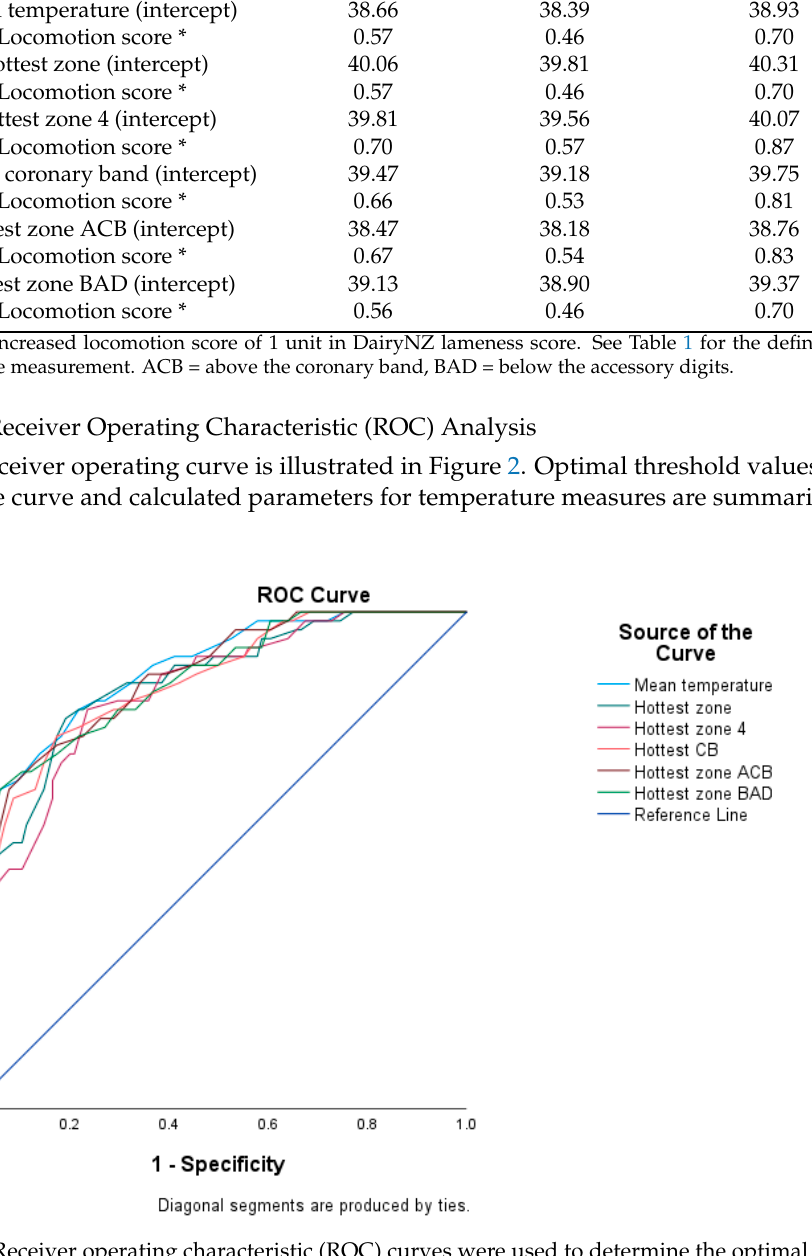
Figure 2. Receiver operating characteristic (ROC) curves were used to determine the optimal threshold values for the infrared thermography’s sensitivity and specificity, assuming locomotion scores ≥ 2 as locomotion score = 2 on three dairy farms in Morogoro ( n = 170). Note: coronary band (CB), above the coronary band (ACB), below accessory digit